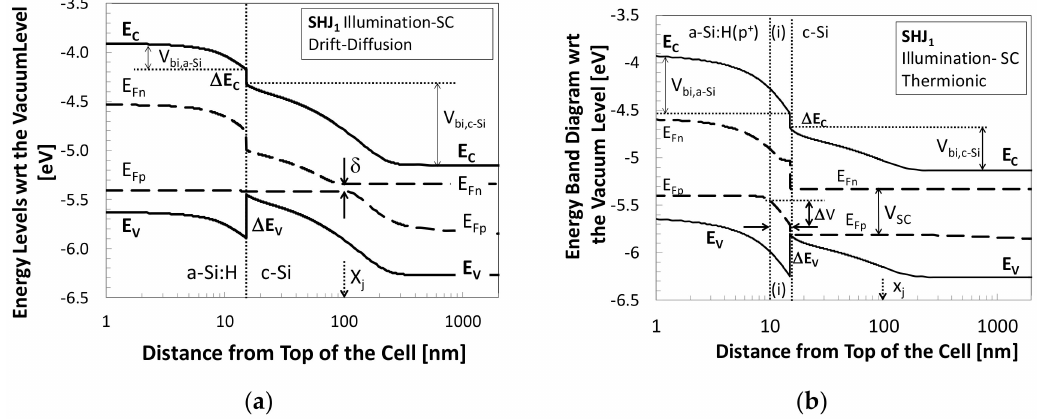
Figure 5. Band diagrams obtained from AFORS-HET simulations of cell SHJ 1 under illumination-SC with ( a ) drift-diffusion and ( b ) thermionic emission transport [35]. Table 2. Built-in potential in cells SHJ 1 and SHJ 4 under